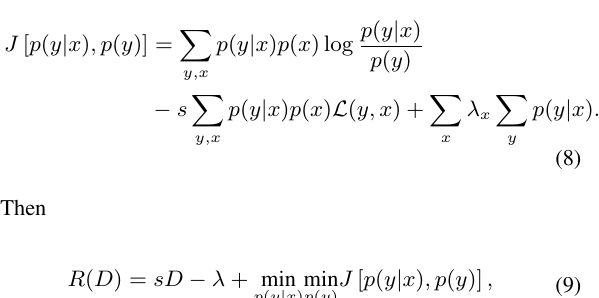
Fig. 1. Agent-environment interaction from a rate distortion theory perspective.